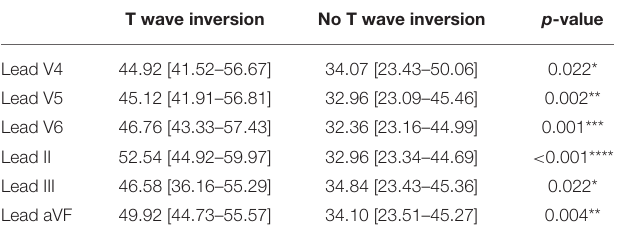
TABLE 3 | The PICP/ICTP ratios of patients who showed a T wave inversion compared to patients who did not show a T wave inversion in different leads of the